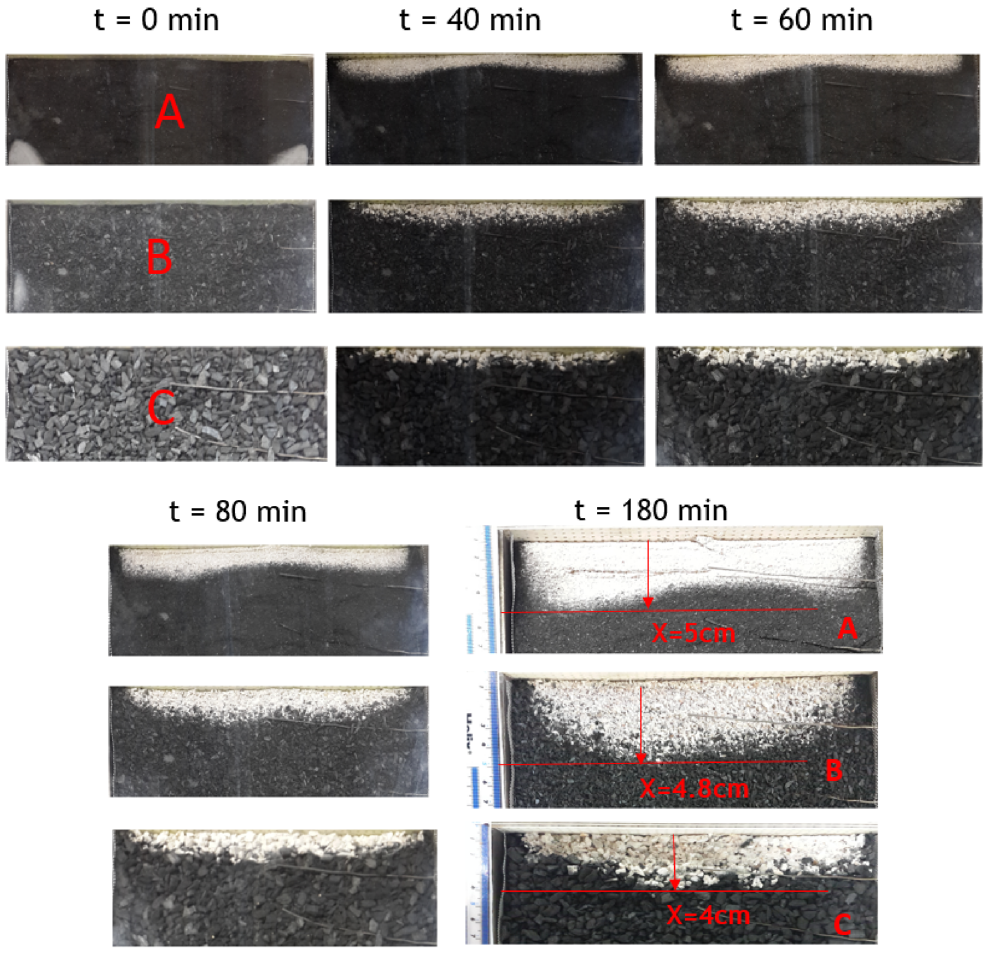
Fig. 8 The reaction propagation over a certain time period for coals A, B, and